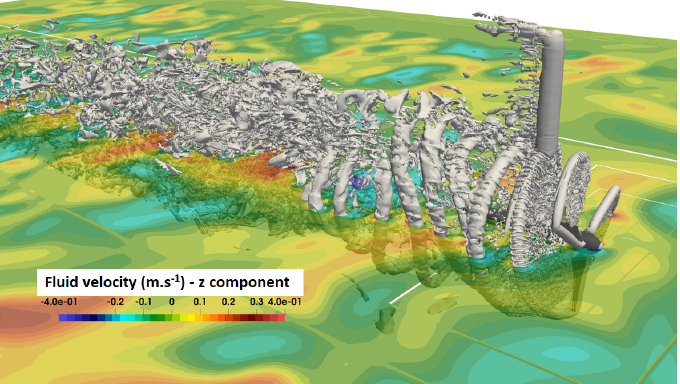
Figure 21. Three-dimensional view of the turbine with an upstream turbulence rate of I = 12.5%, instantaneous U z velocity. Tip-vortices are observable with iso-contour of the lambda 2 criterion. LBM-LES simulation with mesh No.